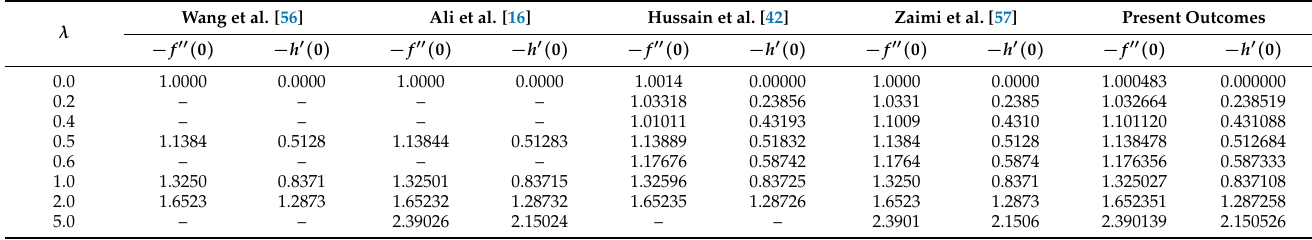
Table 2. Comparative results for − f (cid:48)(cid:48) ( 0 ) and − h (cid:48) ( 0 ) for diverse amounts of λ in case of β = 0, K 1 = 0, M =